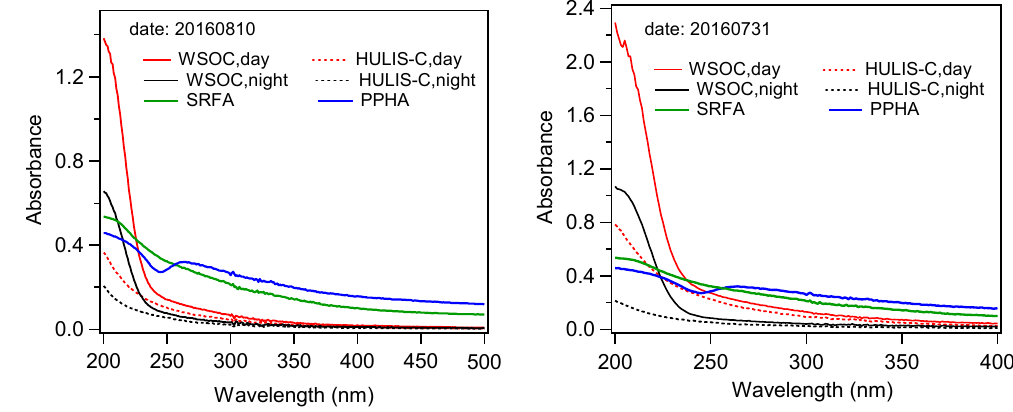
Figure 6. UV-Vis absorption spectra of HULIS-C and WSOC isolated from day and night PM 2.5 samples collected on 10 August and 31 July 2017. Two standard humic substances (Suwannee River fulvic acid (SRFA) and Pahokee Peat Humic Acid (PPHA)) were also presented in the figure.